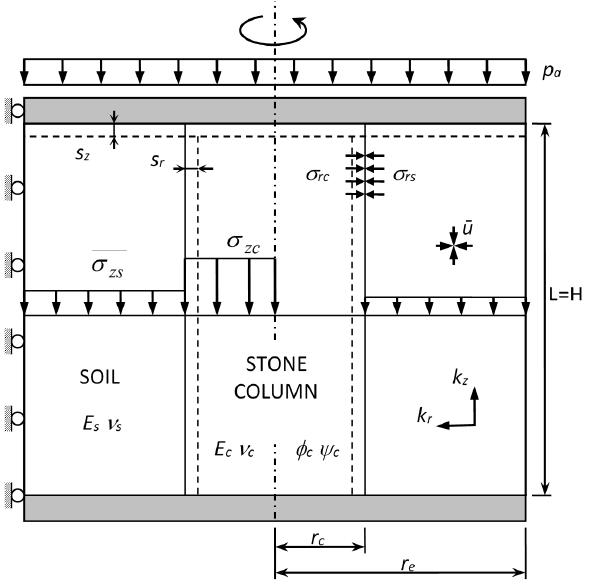
Figure 3. Unit cell model for analytical solutions.